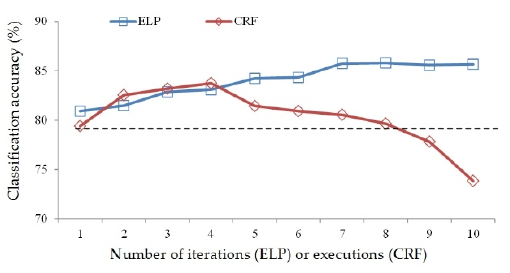
Figure 7. Graphical comparison of the classification accuracy of the two methods.